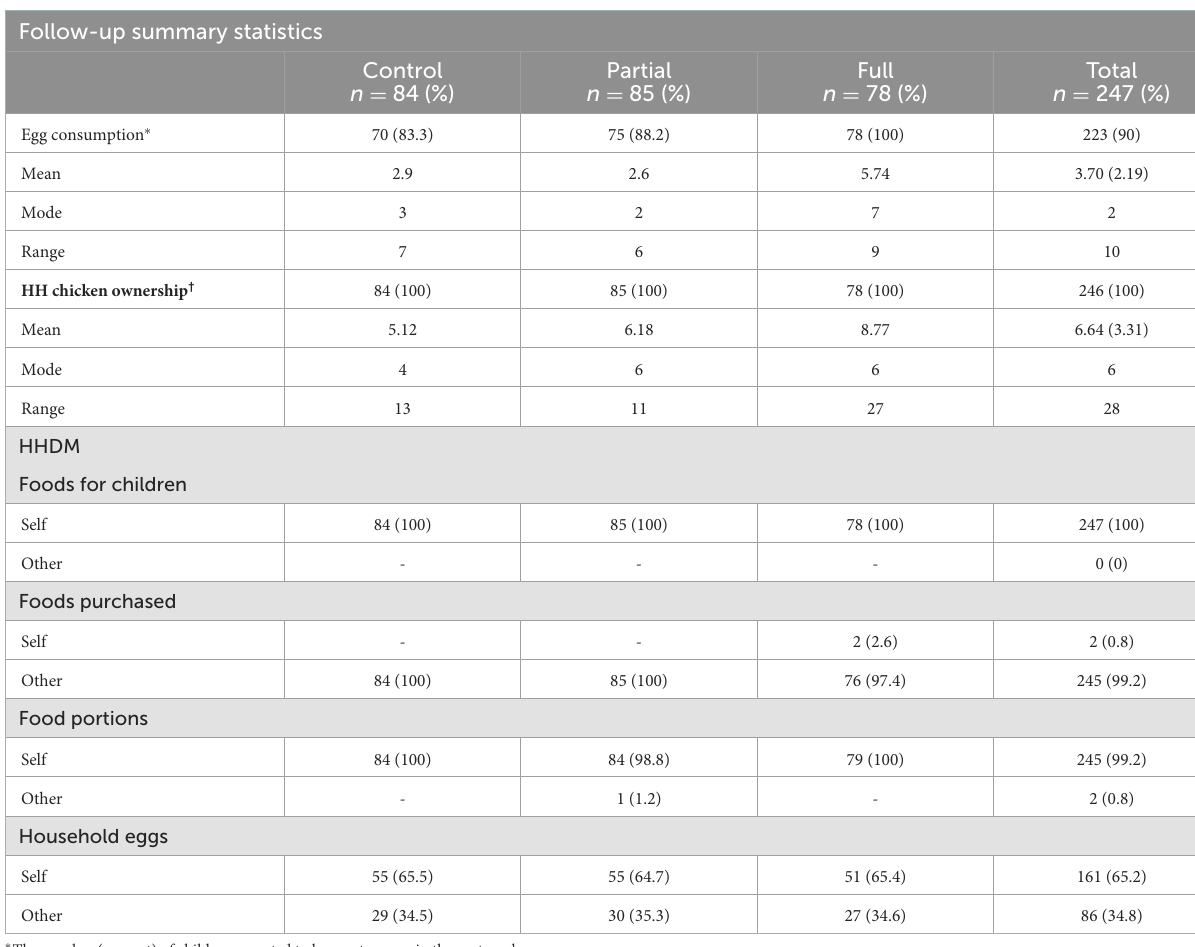
TABLE 1 Egg consumption, household chicken ownership, and household decision-making (HHDM) at the three-month follow-up of the Un Oeuf study population by research arm. Follow-up summary